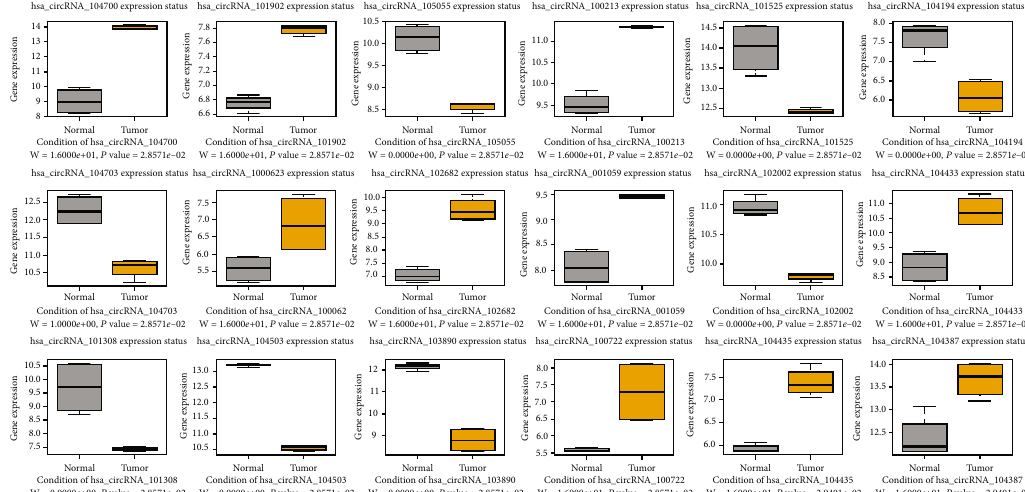
Figure 5: Expression pro fi les of the 18 hub circRNAs between bladder cancer and normal groups. The signi fi cant di ff erence was under the condition of P value <